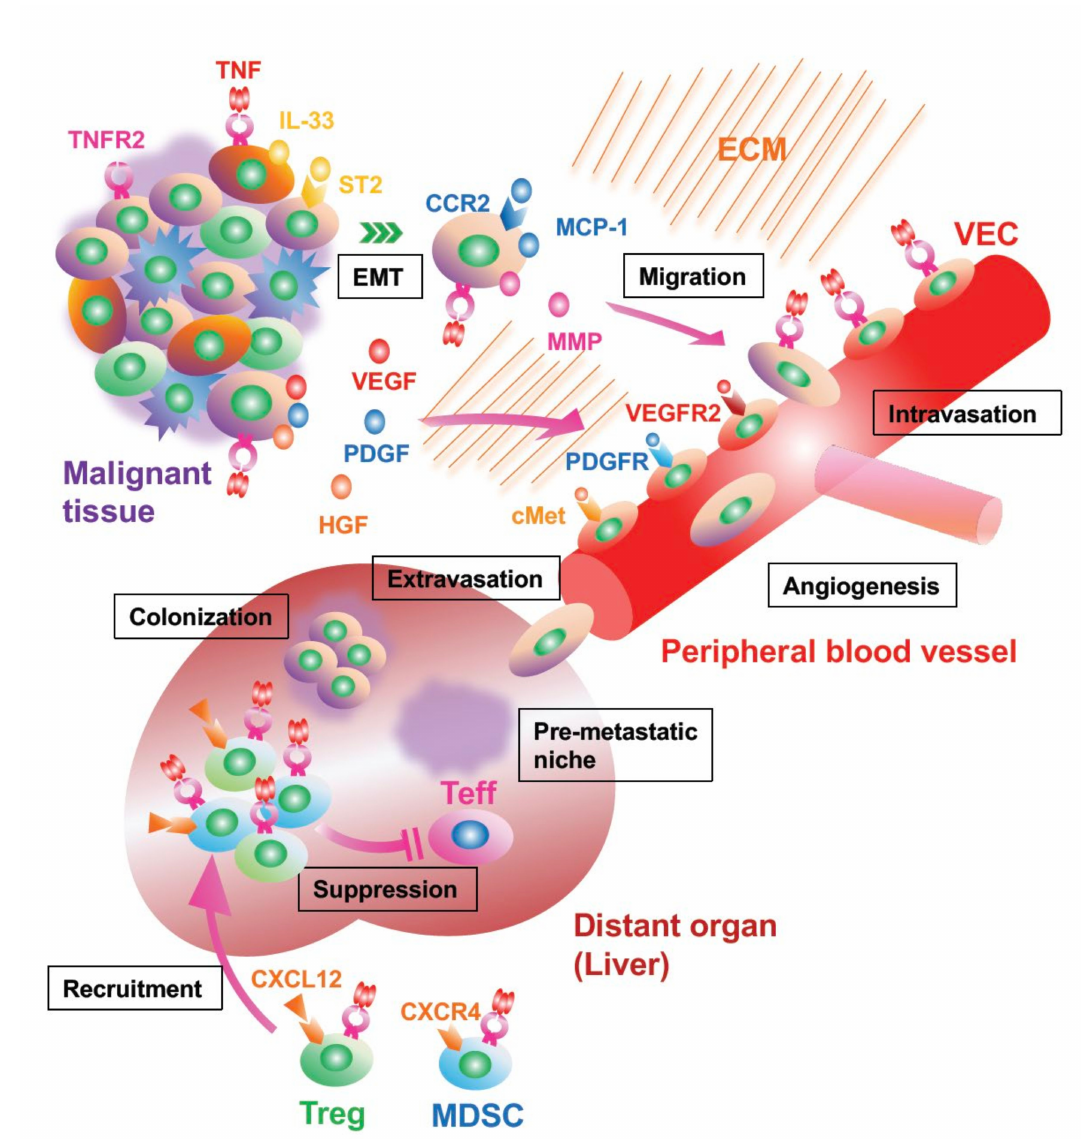
Figure 3. Emerging mechanisms of cancer metastasis via TNFR2 signaling. Cancer cells can leave malignant tissue and migrate into the extracellular matrix (ECM) by the endothelial mesenchymal transition (EMT), a process driven via IL-33 released from cancer-associated fibroblast (CAF) activated via TNF/TNFR2 signaling. By autocrine action of macrophage chemotaxis protein-1 (MCP-1) and secretion of matrix metalloprotease (MMP), the cancer cell invades into the blood capillary newly generated by angiogenesis. The proliferation of vascular endothelial cell (VEC) is also accelerated via TNFR2 signaling in addition to the interaction of vascular endothelial growth factor (VEGF)/VEGFR2, platelet derived growth factor (PDGF)/PDGFR, and hepatocyte growth factor (HGF)/cMet. Before and after the metastasis, TNFR2 + regulatory T cells (Tregs) and myeloid-derived suppressor cells (MDSCs) are recruited to the site from bone marrow with upregulated C-X-C motif chemokine receptor 4 (CXCR4) expression after the binding of TNF. These immunosuppressor cells can